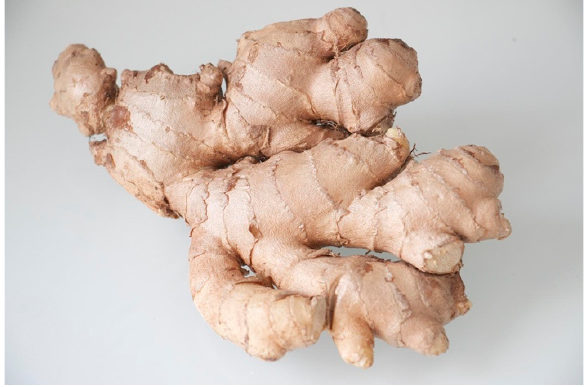
Figure 1. Root of Zingiber officinale